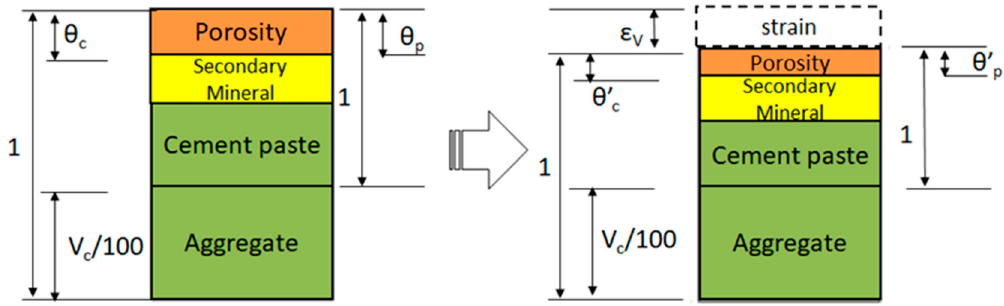
Figure 7. Strain-porosity component model for cement materials. 𝜃 (cid:3030) is the total porosity calculated in GARFIELD-CHEM, 𝑉 (cid:3030) is the percentage volume occupied by incompressible aggregate (non-porous) and 𝜃 (cid:3043) is the corresponding porosity in the porous media fraction of the total volume. After volumetric strain 𝜀 (cid:3023) is applied, porous media components are distorted and total porosity and porous media porosity are reduced, while the aggregate volume remains constant.